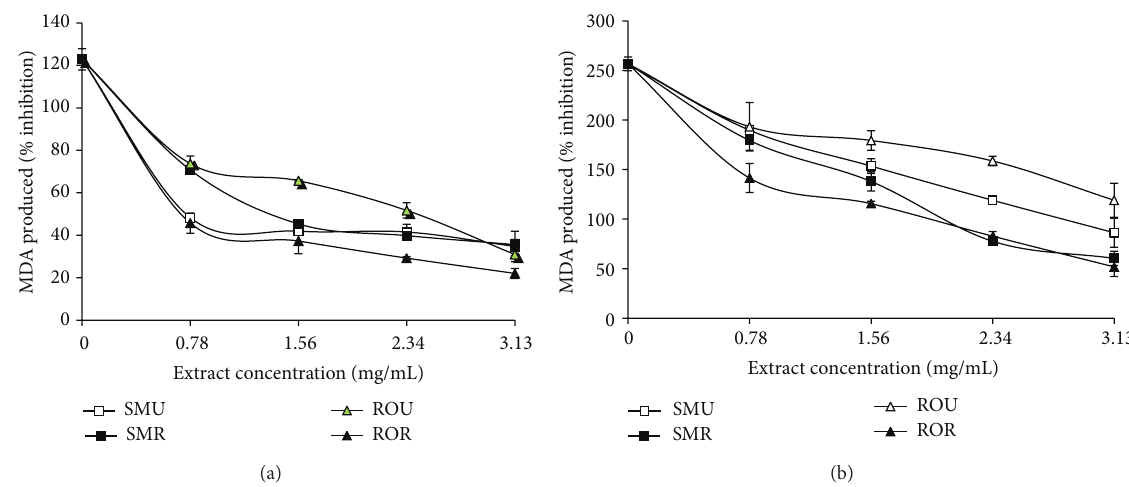
Figure 3: (a) Inhibition of Fe 2+ induced lipid peroxidation in the brain by aqueous extract of Capsicum spp. (b) Inhibition of quinolinic acid induced lipid peroxidation in the brain by phenolic extracts of Capsicum spp. SMU: Capsicum annuum var. accuminatum (unripe). SMR: Capsicum annuum var. accuminatum (ripe). ROU: Capsicum chinense (unripe). ROR: Capsicum chinense (ripe).